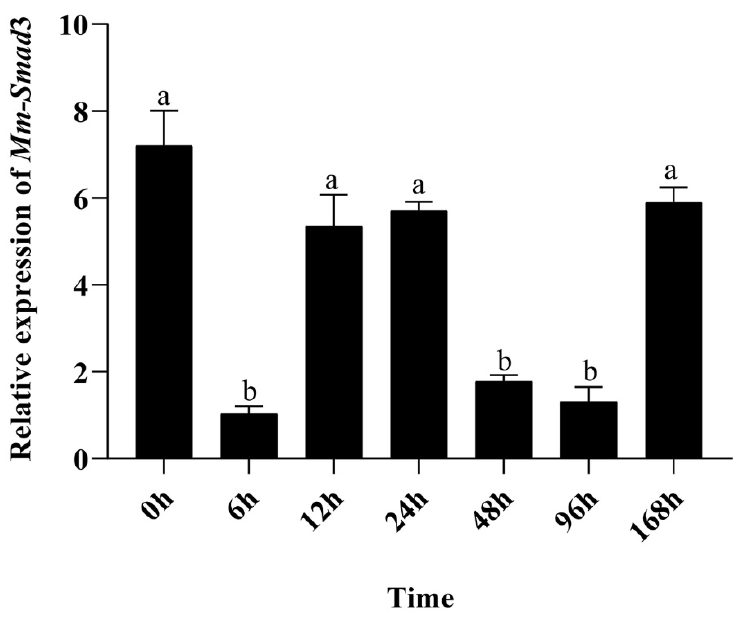
Figure 5. Time-course quantitative expression of Mm-Smad3 after mantle damage repair. Different letters on the columns represent statistically significant differences at p < 0.05.